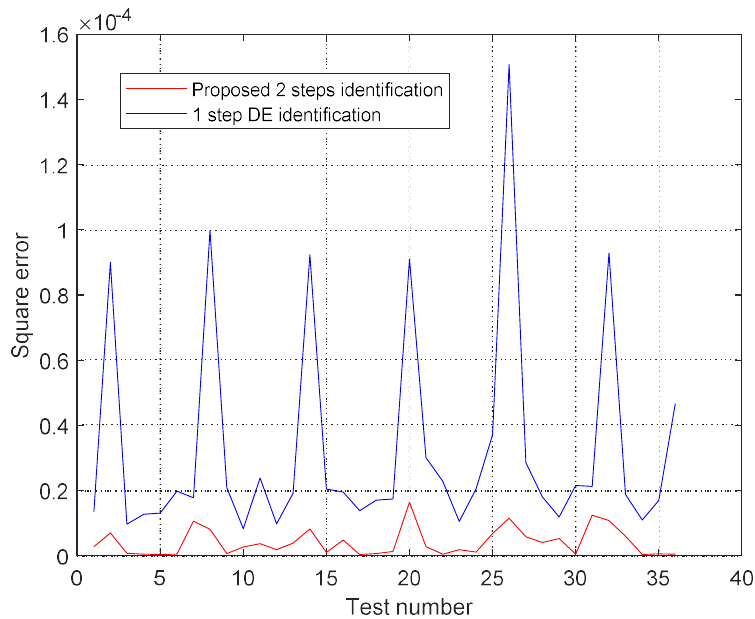
Figure 2. Square errors with proposed identification and with only DE algorithm identification. Table 5. Mean and standard deviation improvement related to one differential evolution optimization. Mean Improvement with Two-Step Standard Deviation with Two-Step Optimization Optimization in %